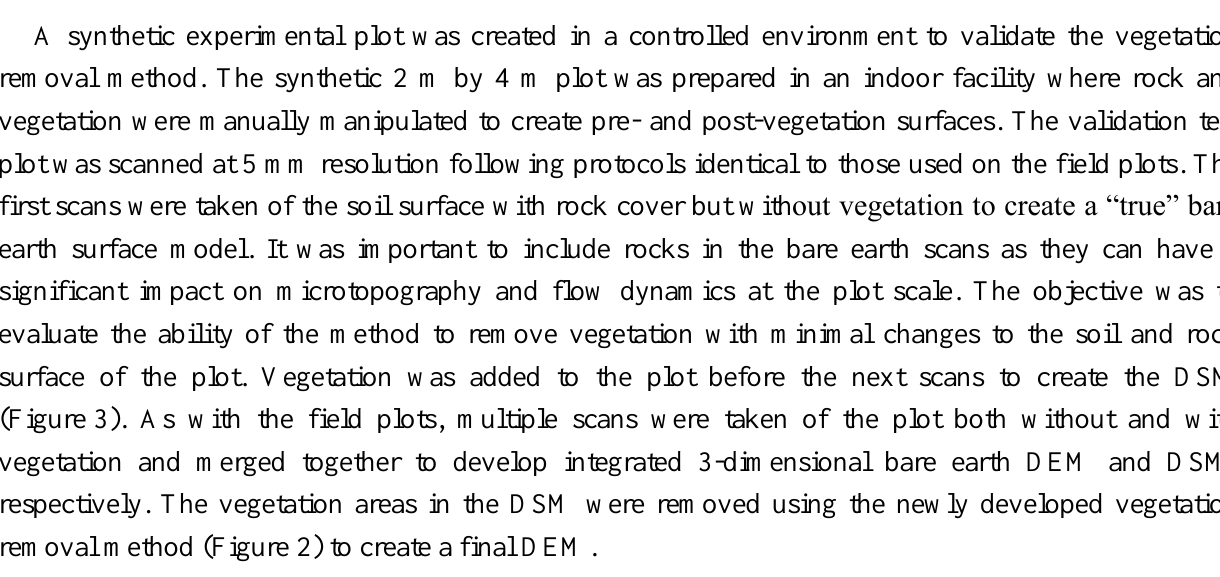
Figure 3. Photos of the synthetic validation plot with and without